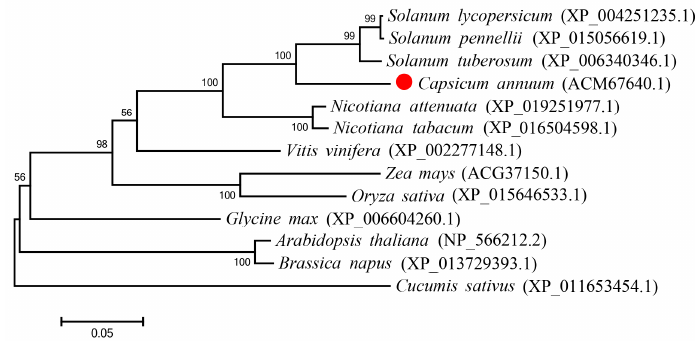
Figure 2. Phylogenetic tree of CaBPM4 proteins and their homologues in other species. The rooted gene tree (majority-rule consensus from 1,000 bootstrap replicates) resulted from was obtained by a heuristic searching in using MEGA6.0. Bootstrap values are indicated at each branch node. GenBank accession numbers are in parentheses after each species and gene name. The red point represents CaBPM4 (ACM67640.1). Scale bar indicates the similarity coefficient.